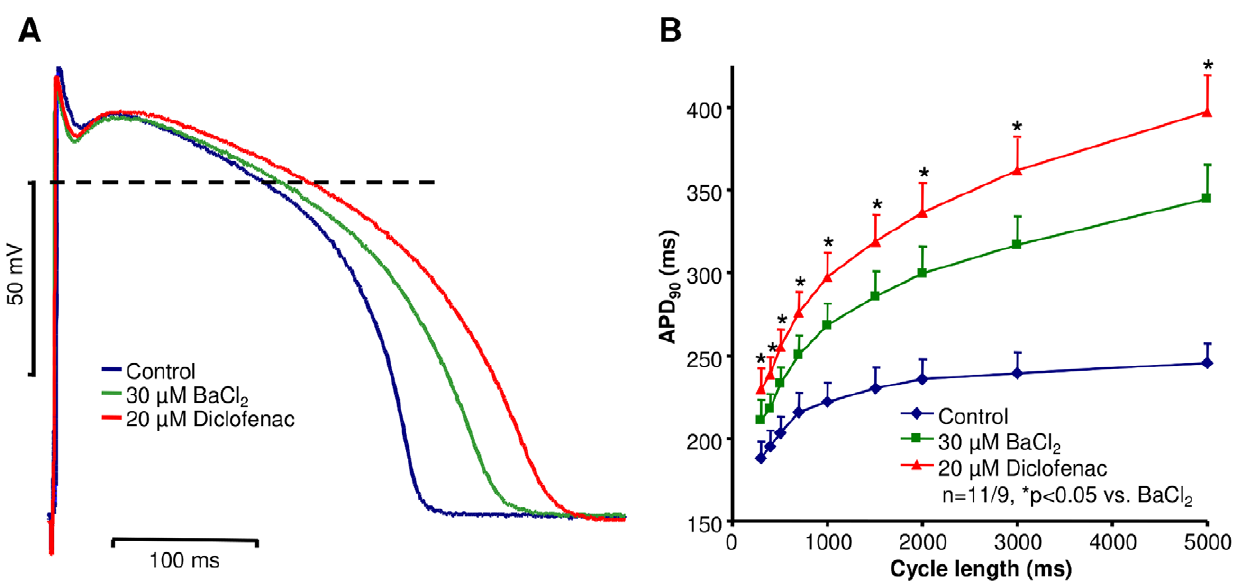
Figure 2. Effect of diclofenac on action potential repolarization in canine right ventricular preparations with impaired repolarization reserve. (A) Representative superimposed action potentials recorded from canine right ventricular muscle preparation at cycle length of 1 s. In these experiments 30 m M BaCl 2 was applied to attenuate the repolarization reserve prior to 20 m M diclofenac superfusion. (B) Cycle length dependent changes in APD 90 measured under the specified experimental conditions in canine right ventricular muscle preparation. Data are expressed as mean 6 SEM, n=number of measurements/number of animals.